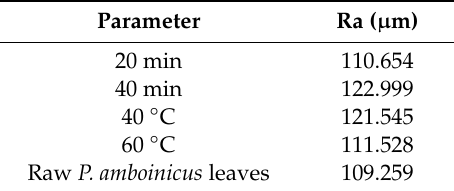
Figure 8. SEM image of leaves after UAE: ( a ) at 40 ◦ C; ( b ) at 60 ◦ C. Table 6. Roughness value, Ra, for UAE SEM images.